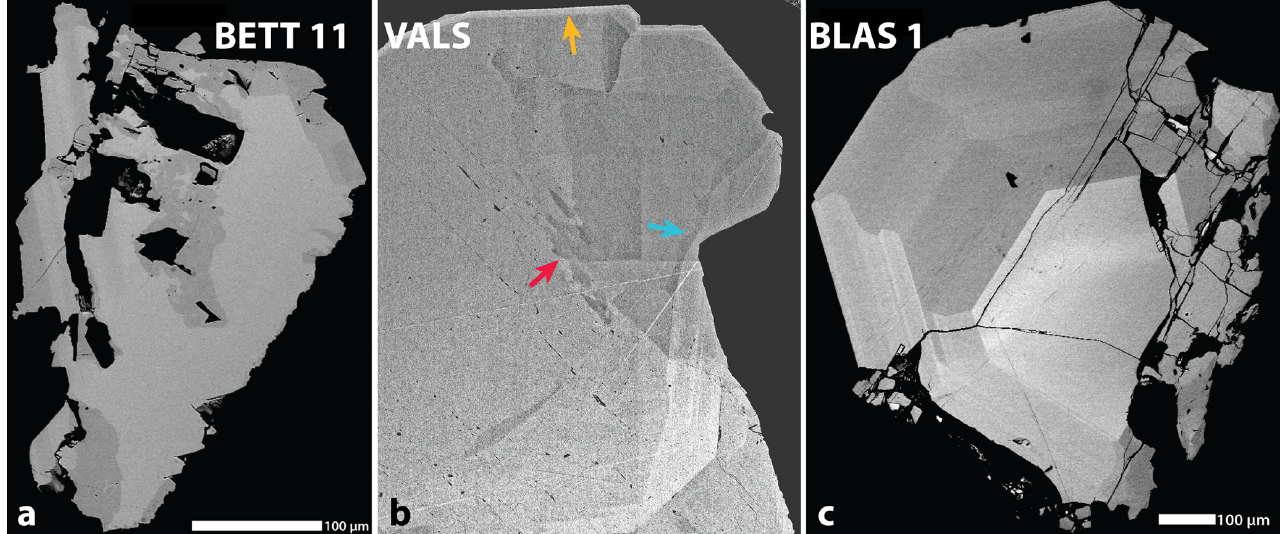
Figure 2. Backscattered electron (BSE) images of monazite-(Ce) samples showing different kinds of internal primary and alteration struc- tures. (a) The dark grain areas of the grain, primarily located close to rims and inclusions, display sharp irregularly shaped borders and porosity. These areas consist of secondary monazite that is ca. 2.5Myr younger than the lighter grain parts (Fig. 5b). Panel (b) shows part of a large grain with partially preserved sector-like zonation. Indications for alteration are irregularly shaped secondary zonation, both patchy in the middle (red arrow) and wavy on the right side (blue arrow), as well as porosity and fractures. The light rim visible at the top (orange arrow) likely represents a late overgrowth but yields some of the oldest ages of the grain, predating those of some of the interior grain parts by several million years (Fig. 5t). The grain in (c) displays multiple rims combined with sector-like zonation around the core. Although the grain shows practically no alteration features, the outer rim has the oldest and most homogeneous age pattern, with the central part possessing a wider age range with some significantly younger ages (Fig. 5m, Table S1 in the Supplement). The youngest ages were found in part of the inner rim surrounding the core, postdating all other ages measured in the second rim or center by several million